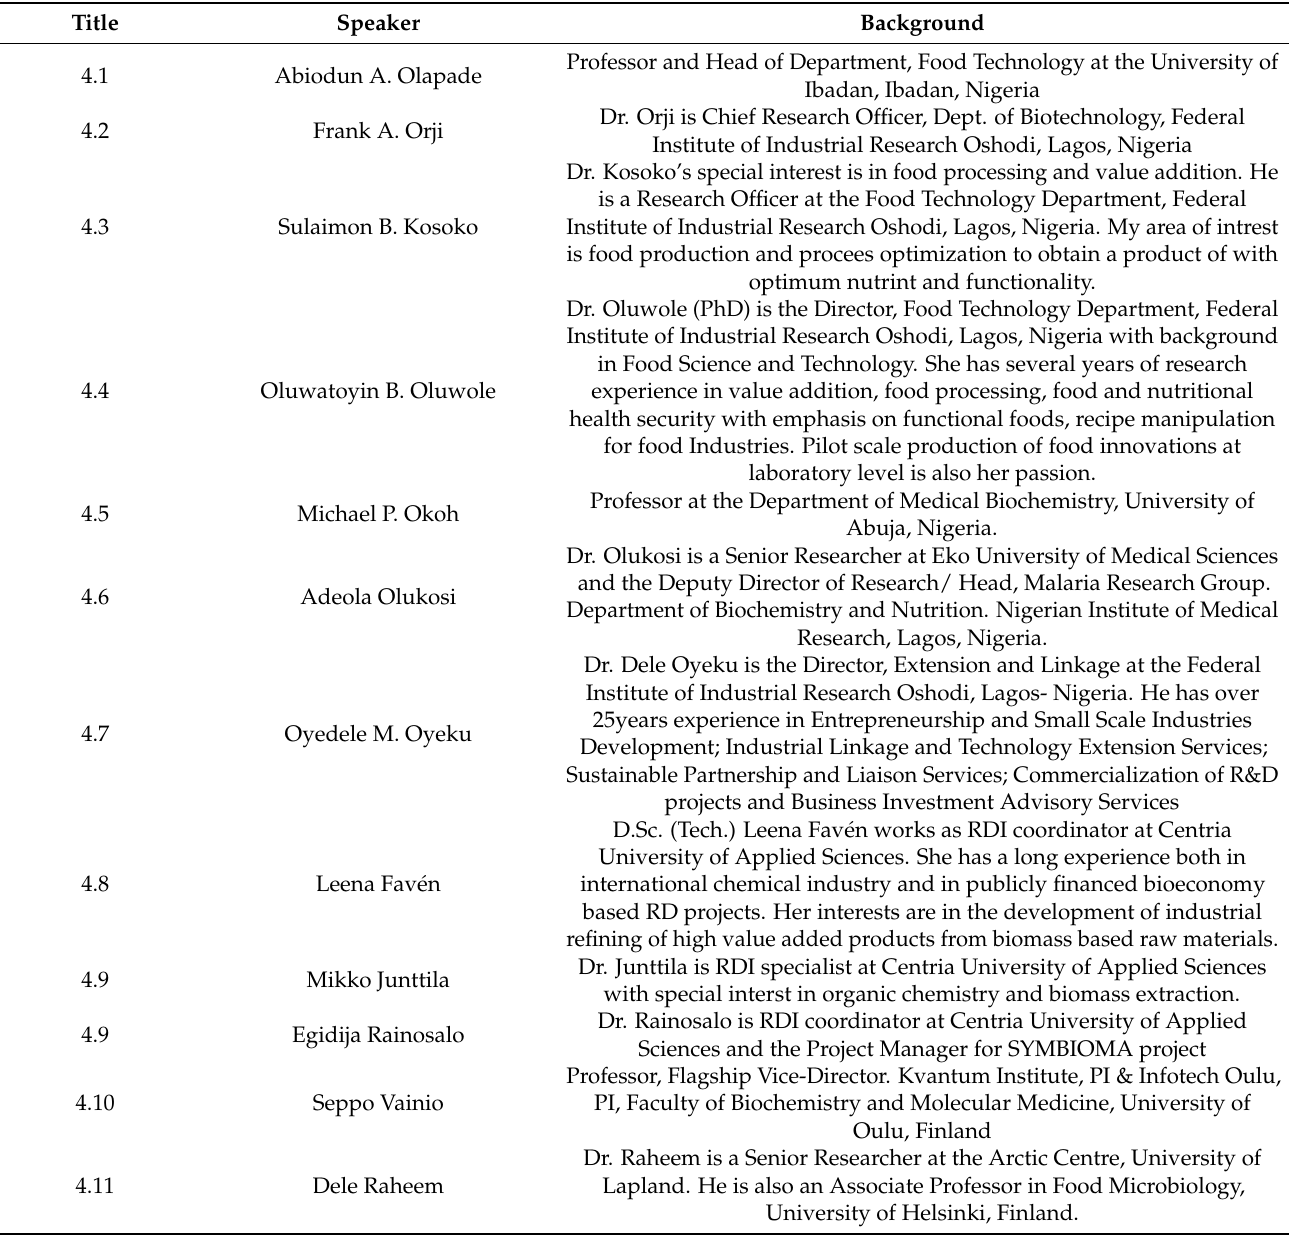
Table A1. A list of the titles presented in the Results and Discussion section, Speakers and their